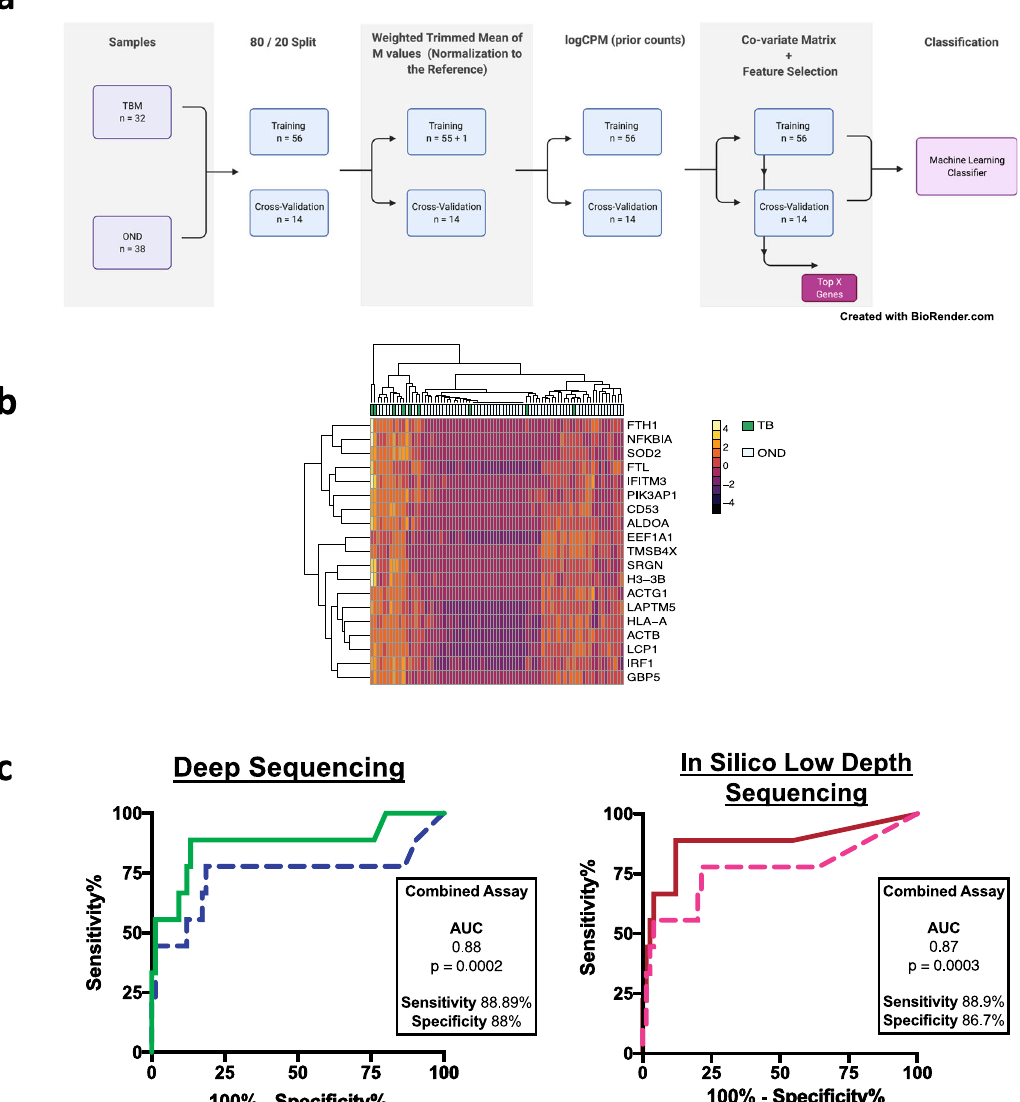
Fig. 1 Development of a host-based machine learning classi fi er from cerebrospinal fl uid RNA-seq data. A Work fl ow for creation of the machine learning classi fi er using 70 microbiologically proven samples, through PCR or conventional testing, identi fi ed in the training cohort. B Most predictive 4 genes of a 15 gene classi fi er to classify TBM vs OND. C Left: ROC curve for the combined mNGS and MLC assay. Blue dotted line is the MLC assay alone, and the green solid line is the combined assay. If the MLC categorized a case as TBM, but mNGS detected a non-TB pathogen, then mNGS overruled the MLC result, thus increasing speci fi city of the overall assay. Right: In silico prediction of shallow depth (i.e., 100,000 reads for the RNA-seq library and 500,000 reads for the DNA-seq library) sequencing results. Pink dotted line is the MLC assay alone, red solid line is combined assay with mNGS. Current cost prediction for shallow depth sequencing in $75 per patient. CPM counts per million, GBP5 guanylate binding protein 5, FTL ferritin light chain, NFKBIA NF- mNGS metagenomic next-generation sequencing, AUC area under the receiver operator curve. Source data are provided as a Source Data fi